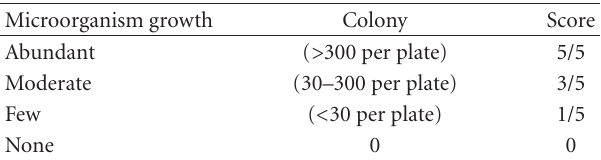
Table 1: Scheme for scoring growth of microorganism based on colony.